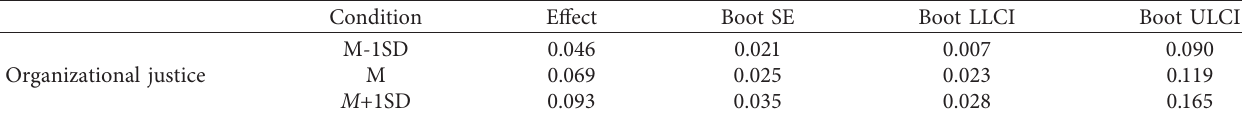
Figure 2: Slope analysis. Table 7: Mediating effects at different levels of organizational